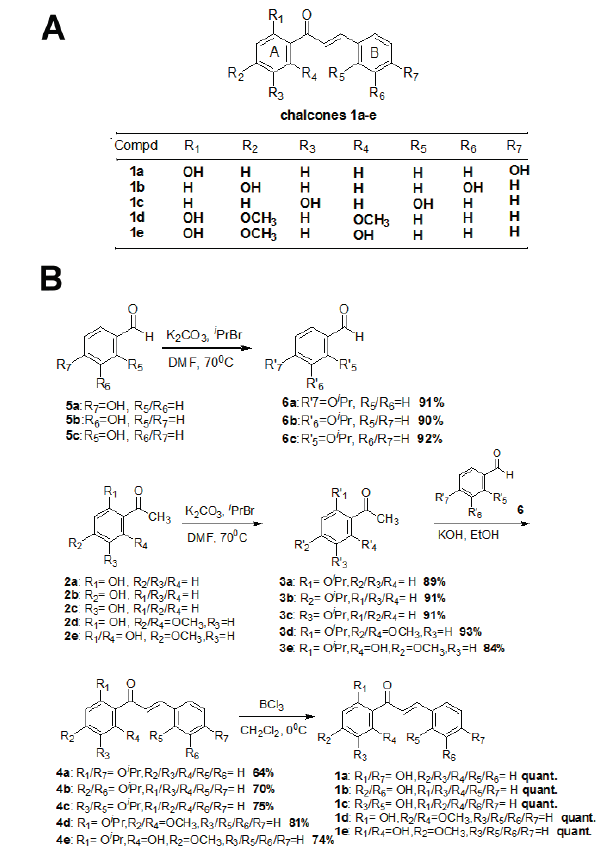
Figure 1. Structures and synthesis of chalcone and its derivatives. ( A ) Structures of chalcone and compound 1a – e ; ( B ) Synthesis of compounds 1a – e